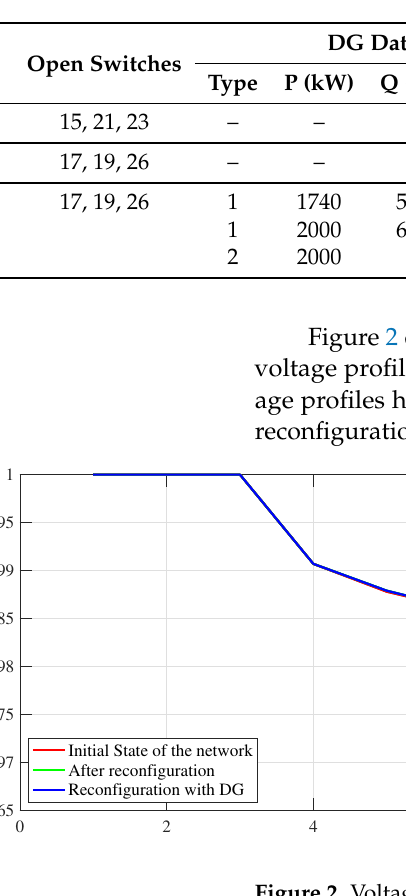
Table 2. Results for the 16-bus test system.